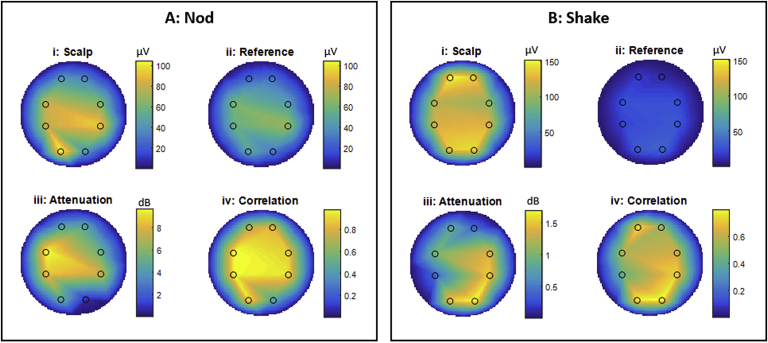
Flat-maps showing the results from EEG experiments on human subjects wearing the RLAS cap. The values shown are calculated as an average across three recordings made in two separate sessions. Box A shows the results for a nod motion, where box B displays the results from a shake motion. i and ii show the RMS values of the EEG data for the channels connected directly to the subject's scalp and the isolated reference layer, respectively. iii shows the attenuations of the scalp artefacts produced by directly subtracting the reference layer recording and iv show the correlation coefficients between timecourses used to generate i and ii. Note the difference in colour-bar scales for head nod and shake movements.